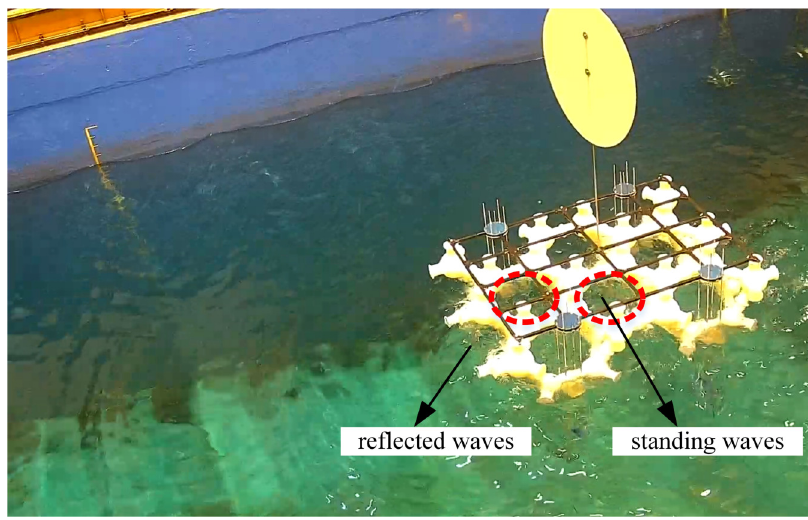
Figure 11. Instantaneous profile of the HFS under regular waves coming from the left (wave frequency: 0.182 Hz, wave height: 1